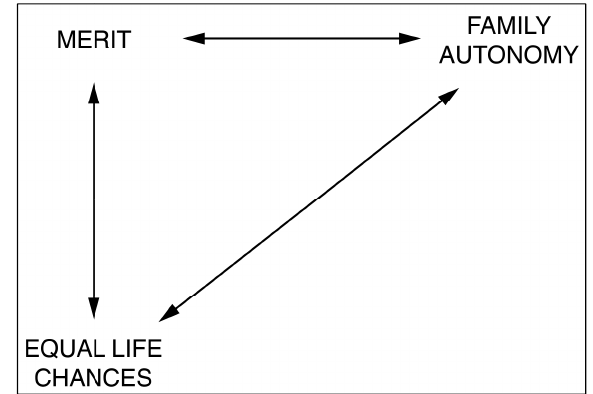
Figure 1. According to James Fishkin, when two assumptions about equal opportunity (the principle of merit and equality of life chances) are combined with a third assumption (autonomy of the family), “a pattern of difficult choices emerges”, whereby “commitment to any two of these assumptions rules out the third” ([21], p. 5).